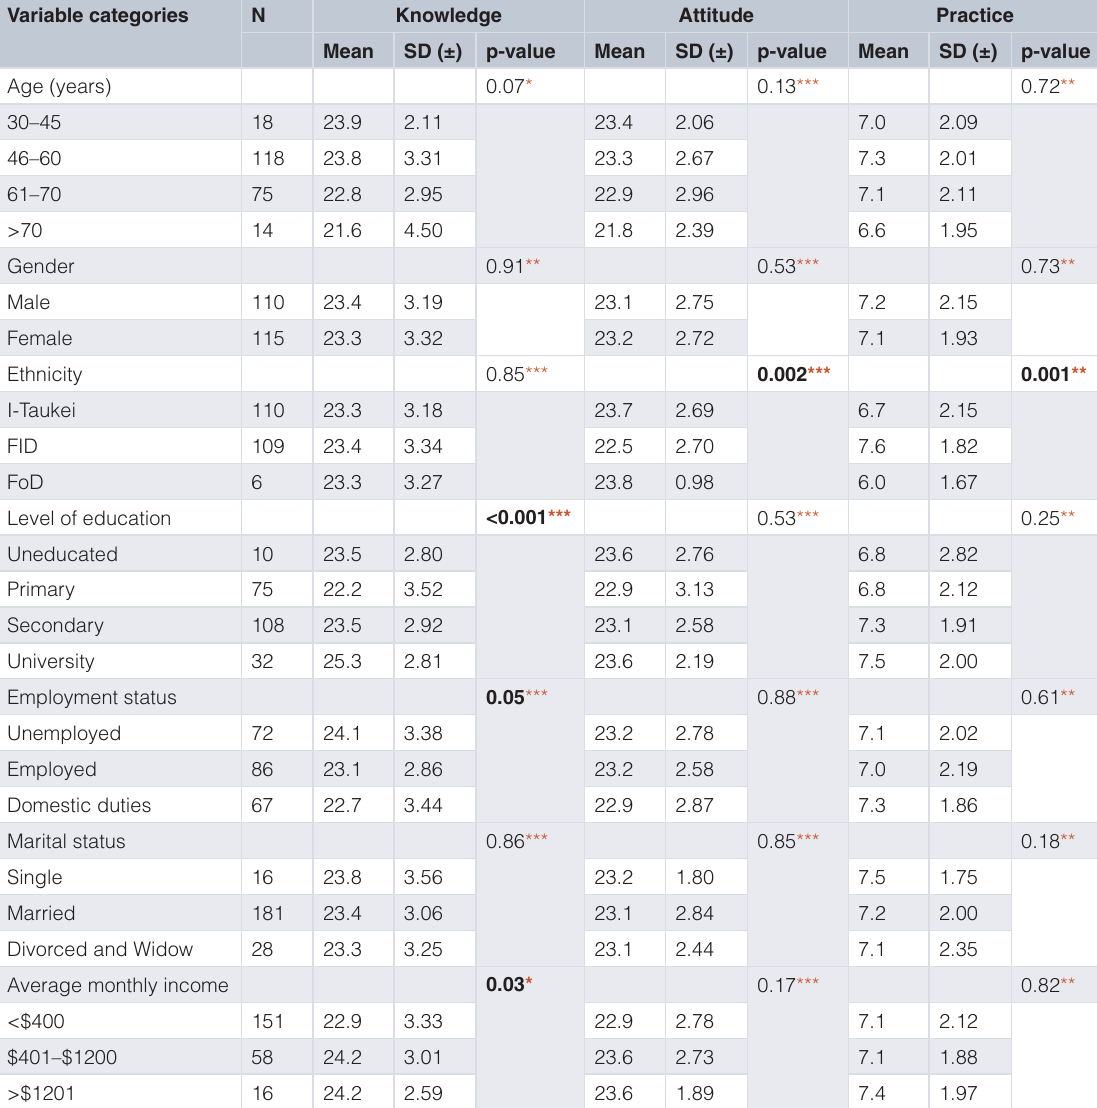
Table 3. Correlation of demographic characteristics and KAP of T2DM patients with CKD (n=225). Variable